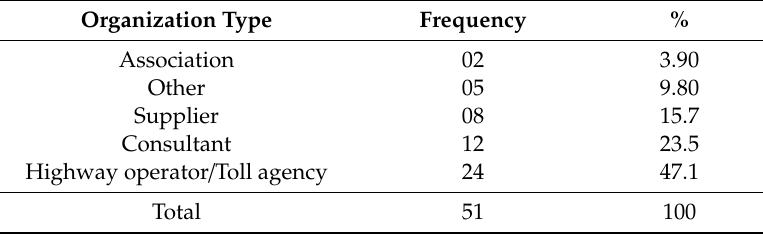
Table 2. Breakup of participating